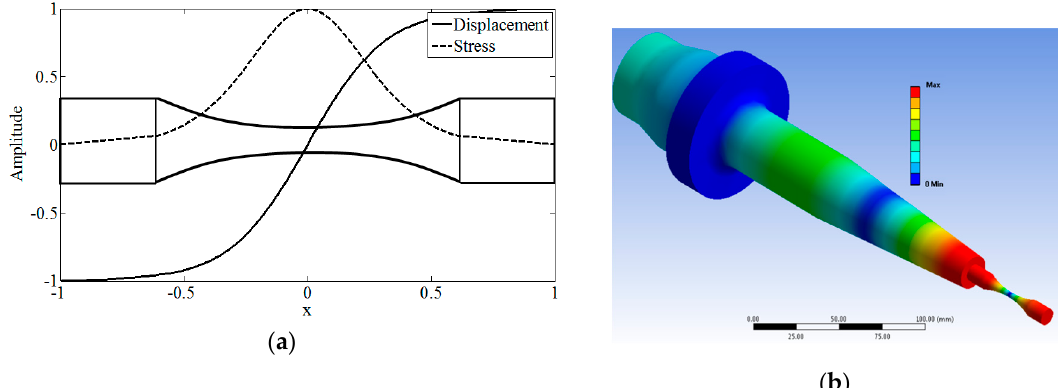
Figure 3. ( a ) Normalised distribution of displacement and stress along the normalised length of a uniaxial UFT specimen [10]; ( b ) Modal analysis simulation results (displacement) for the first axial (tension) mode at 20 kHz of the resonant system components [10].